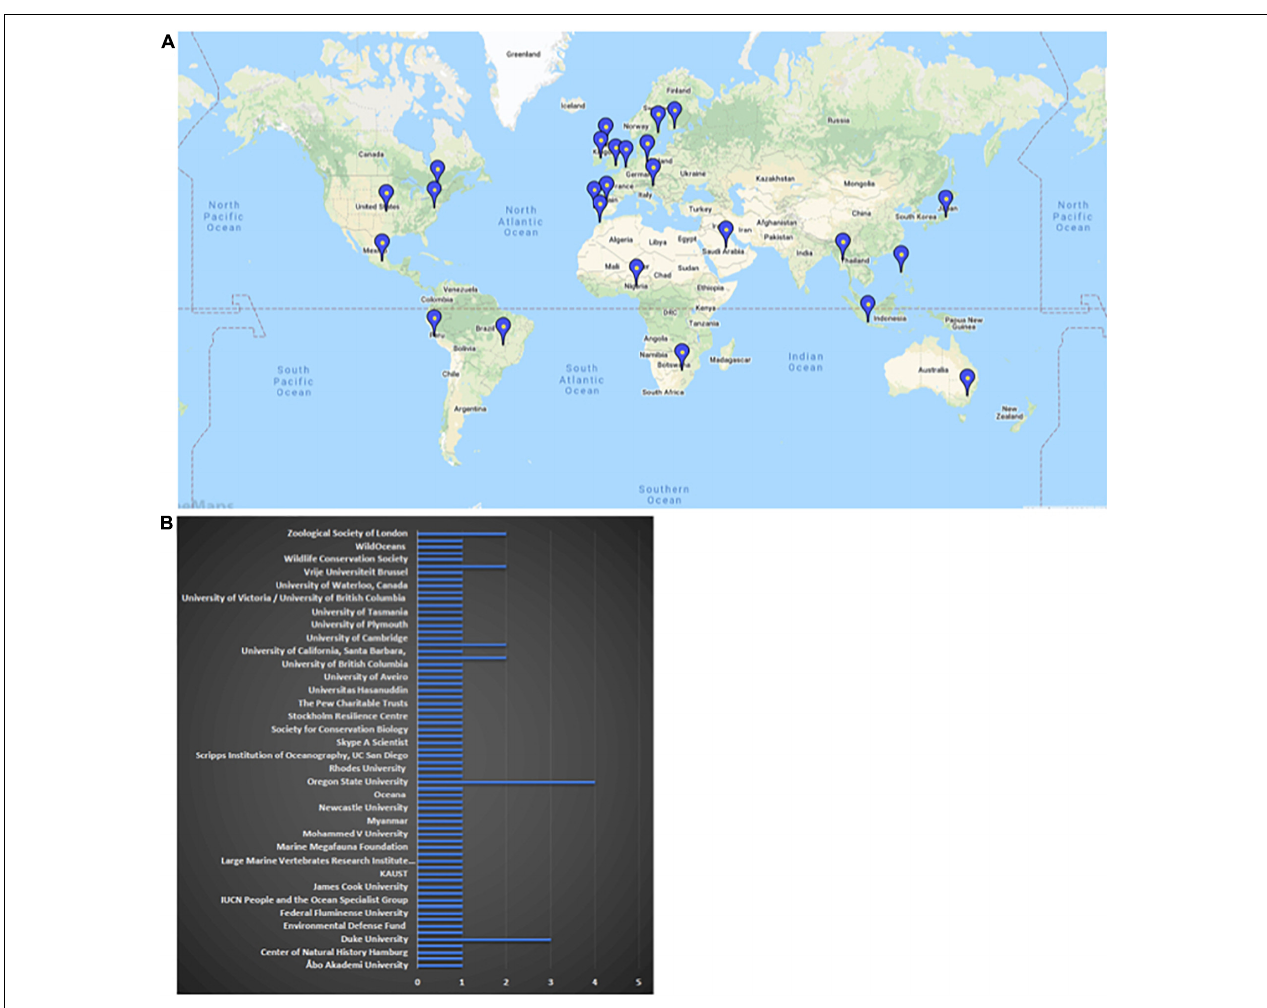
FIGURE 1 | Country of work or nationality (A) and affiliation (B) of those who signed the Statement of Requests to SCB Marine Section and chose to share the